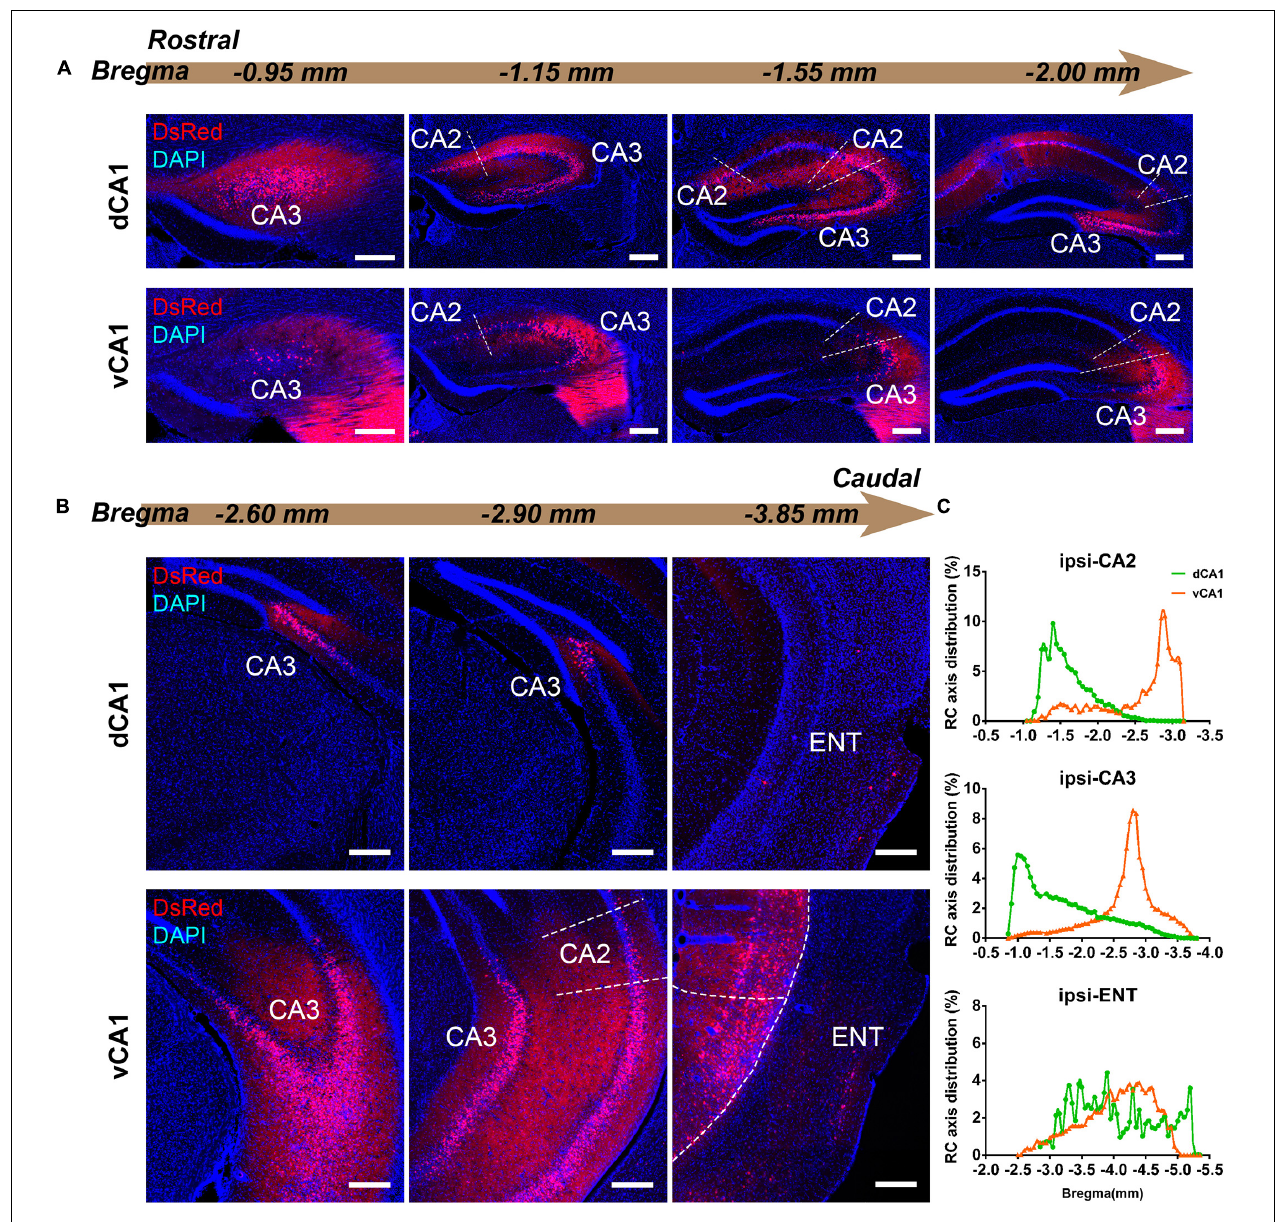
FIGURE 3 | Inputs to CA1 PNs from ipsilateral HIP subregions. (A,B) Representative images showing distributions of the input neurons located in ipsilateral HIP. Scale bar: 250 µ m. (C) Distribution patterns of the input neurons along the RC axis in different subregions of the ipsilateral HIP. In the ipsilateral HIP, the input neurons were found located in CA2, CA3, and ENT in both tracing